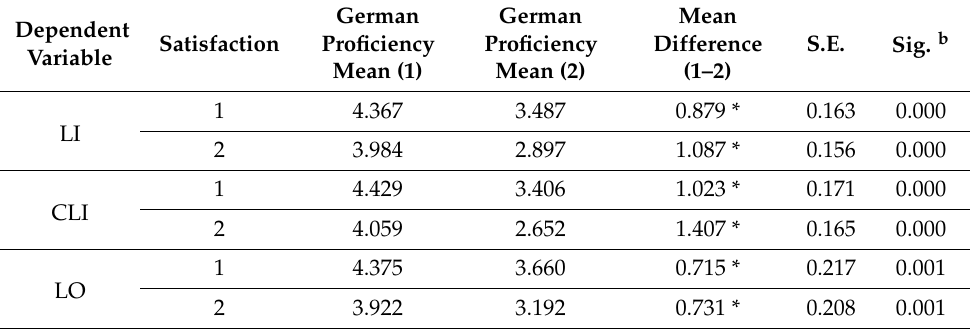
Table 4. MANOVA test for German proficiency. German Dependent Satisfaction Variable